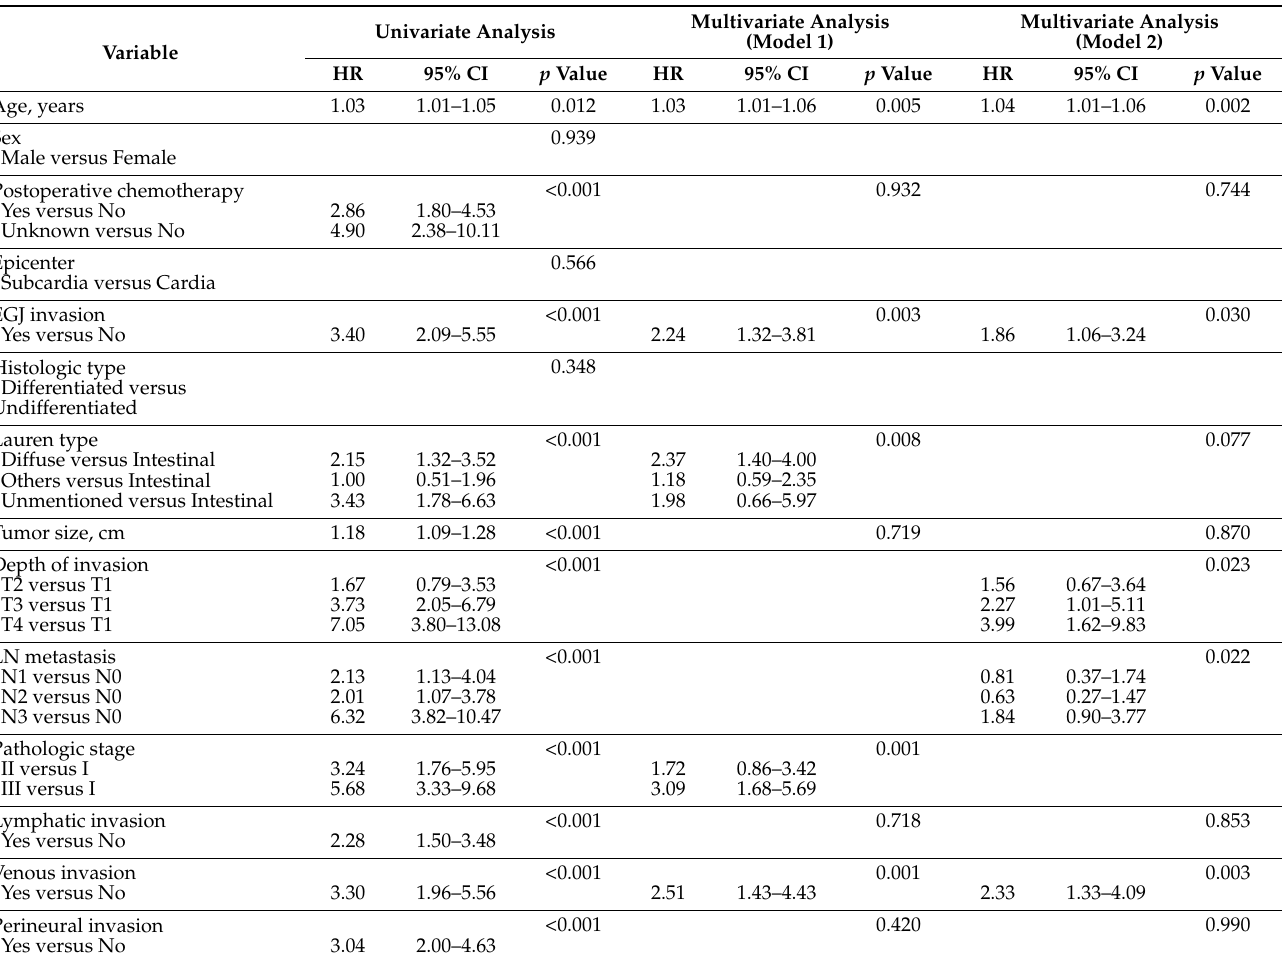
Table 3. Univariate and multivariate analyses of overall survival in patients diagnosed with cardia or subcardia